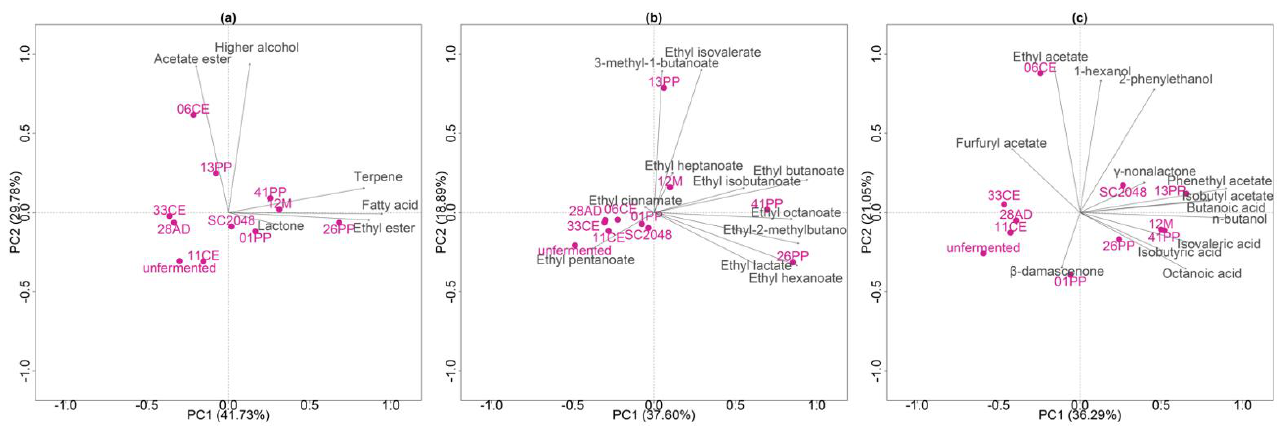
Figure 1. Principal component analysis (PCA) of volatile compounds produced in unfermented and fermented Sauvignon Blanc (SB) musts. ( a ), Inoculation with a commercial strain of S. cerevisiae (2048SC), wild strains of Saccharomyces spp. (26PP, 41PP, 01PP, 12M, 33CE, 28AD, 13PP, 06CE, and 11CE), and unfermented SB must ( b ). Principal component analysis of ethyl ester groups. ( c ), Principal component analysis of higher alcohols, C 13 -norisoprenoids, and fatty acids.